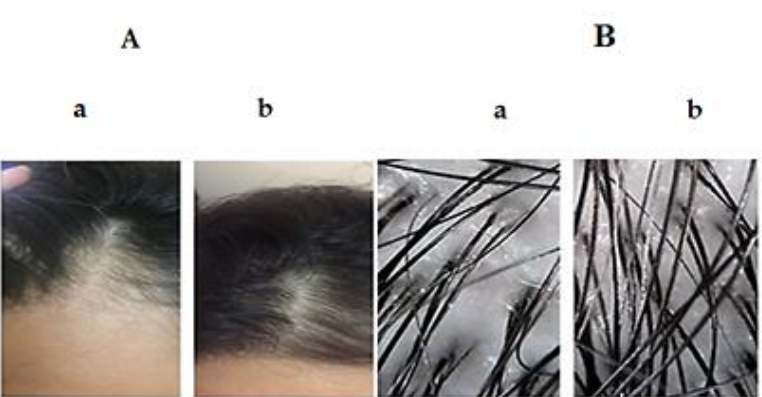
Figure 12. Clinical photographs ( A ), dermoscopic pictures ( B ) of group B; pre-treatment ( a ) and Post-treatment ( b ) with minoxidil.